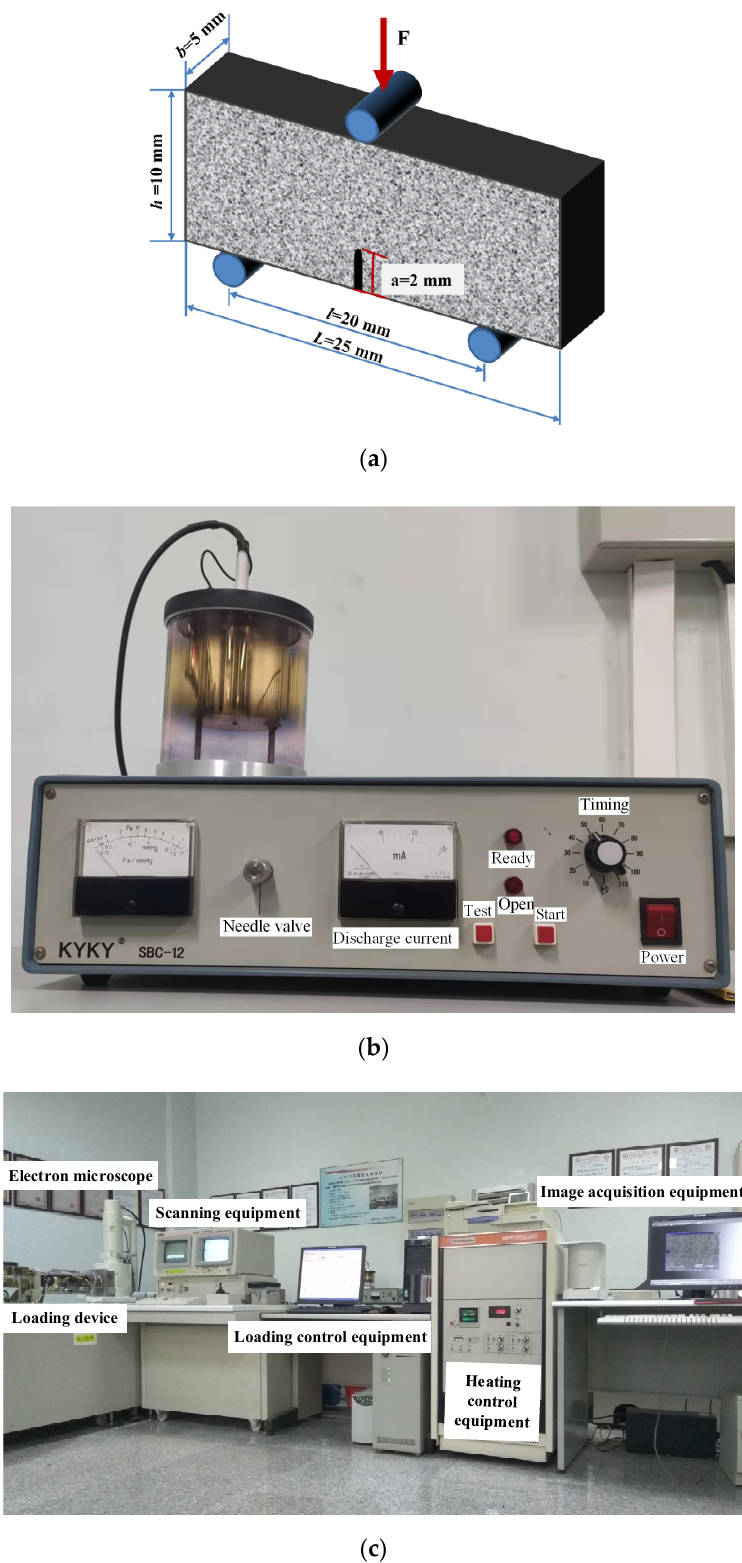
Figure 1. The diagram of coal sample and equipment for three-point bending experiment: ( a ) Diagram of three-point bending specimen; ( b ) Gold-plated equipment; ( c ) SEM fatigue experiment